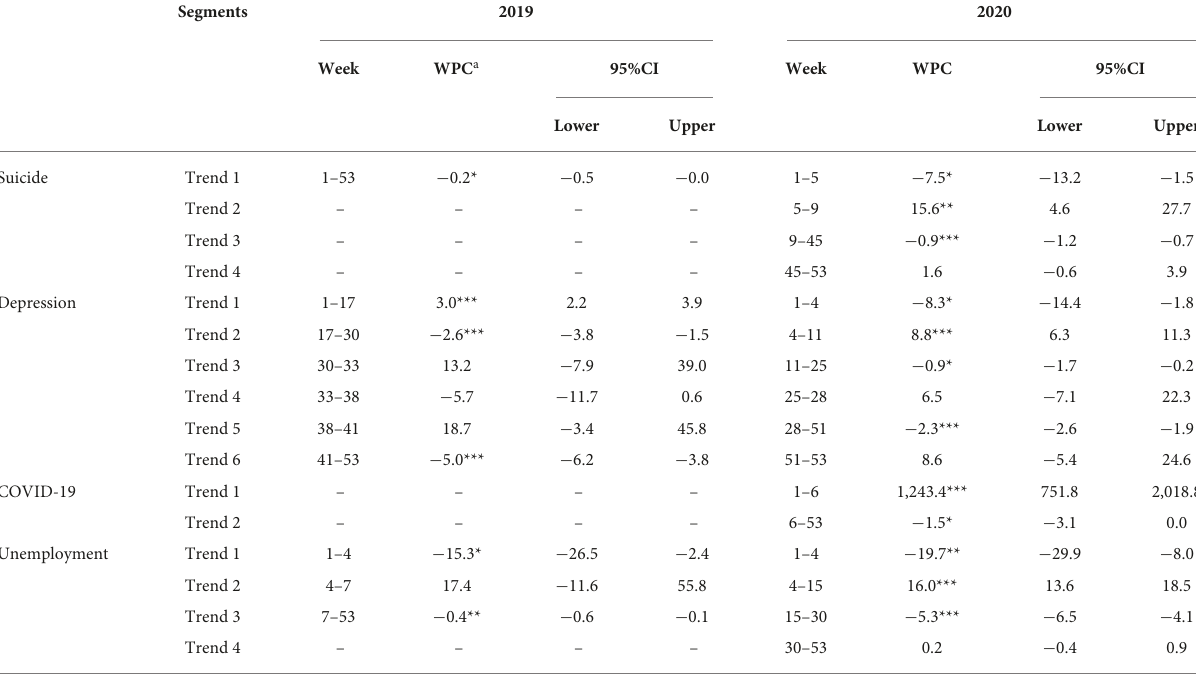
TABLE 1 Trends in Baidu Search Index (BSI)-suicide and associated factors from 1st to 53rd week both in 2019 and 2020 † .